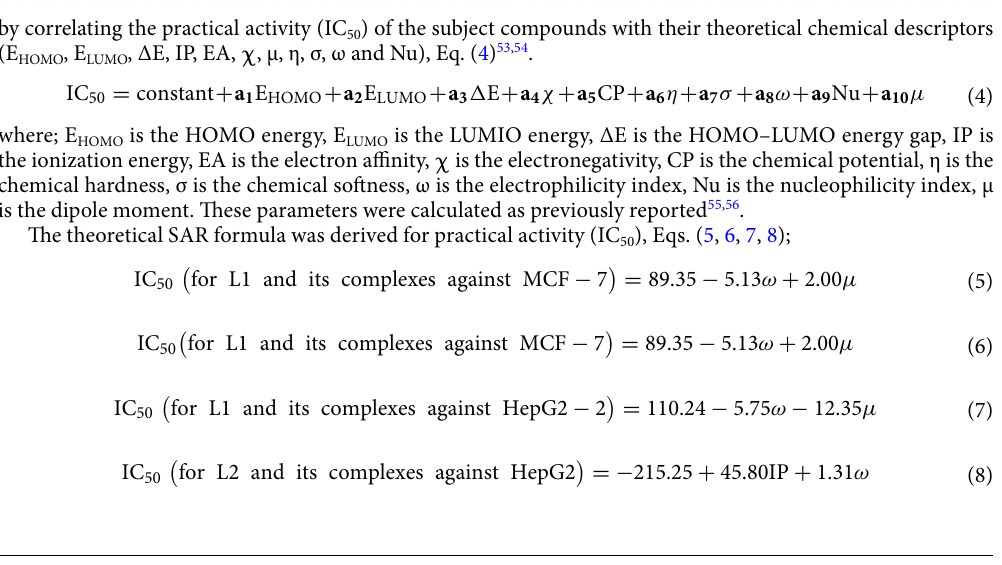
Figure 14. HL1 and HL2 interactions with the human DNA receptor site are shown in a 2D plot together with